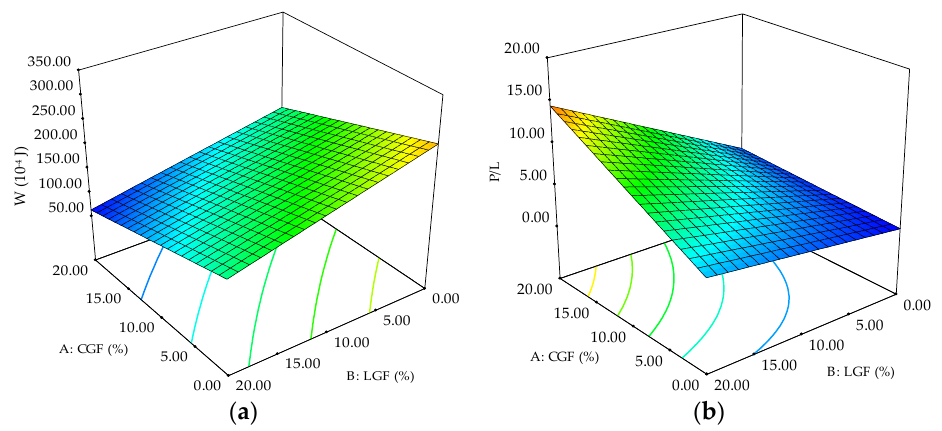
Figure 5. Response surface plot of ( a ) dough alveograph energy (W) and ( b ) alveograph curve ra- tio(P/L) as a function of chickpea germinated flour (CGF) and lupin germinated flour (LGF) addition.